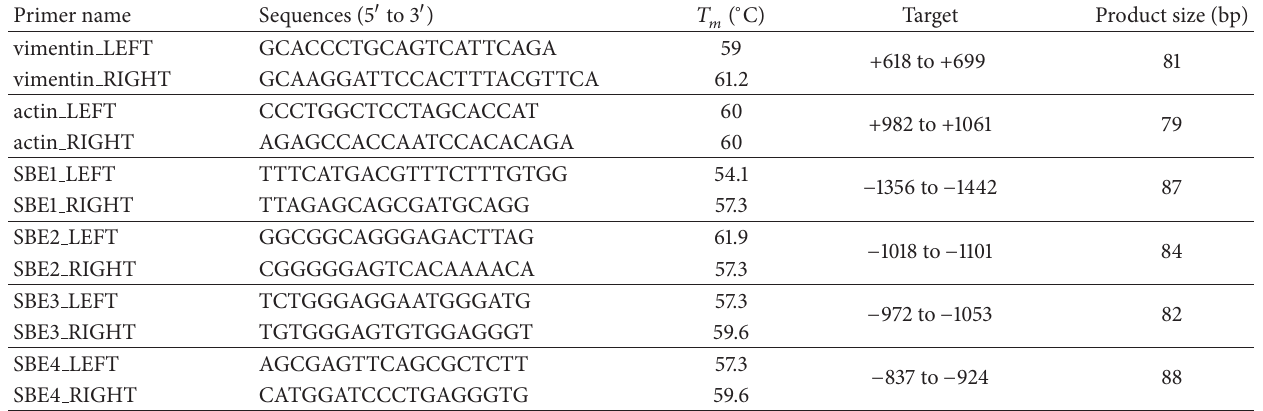
Table 1: List of primers for real-time PCR and